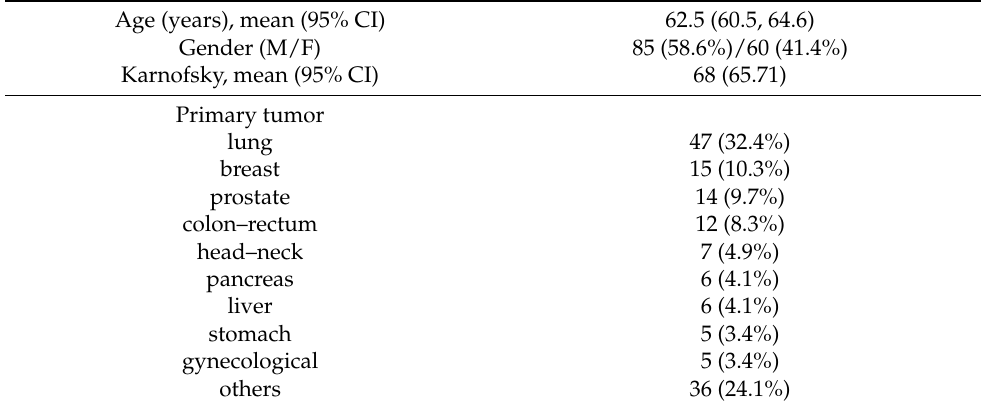
Table 1. Characteristics of patients ( n =